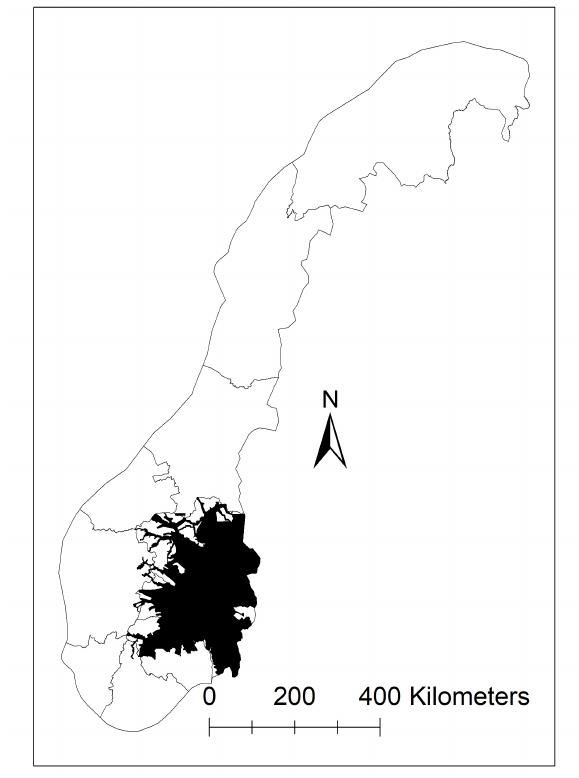
Figure 1. Location of the study area (dark part) in relation to the map of